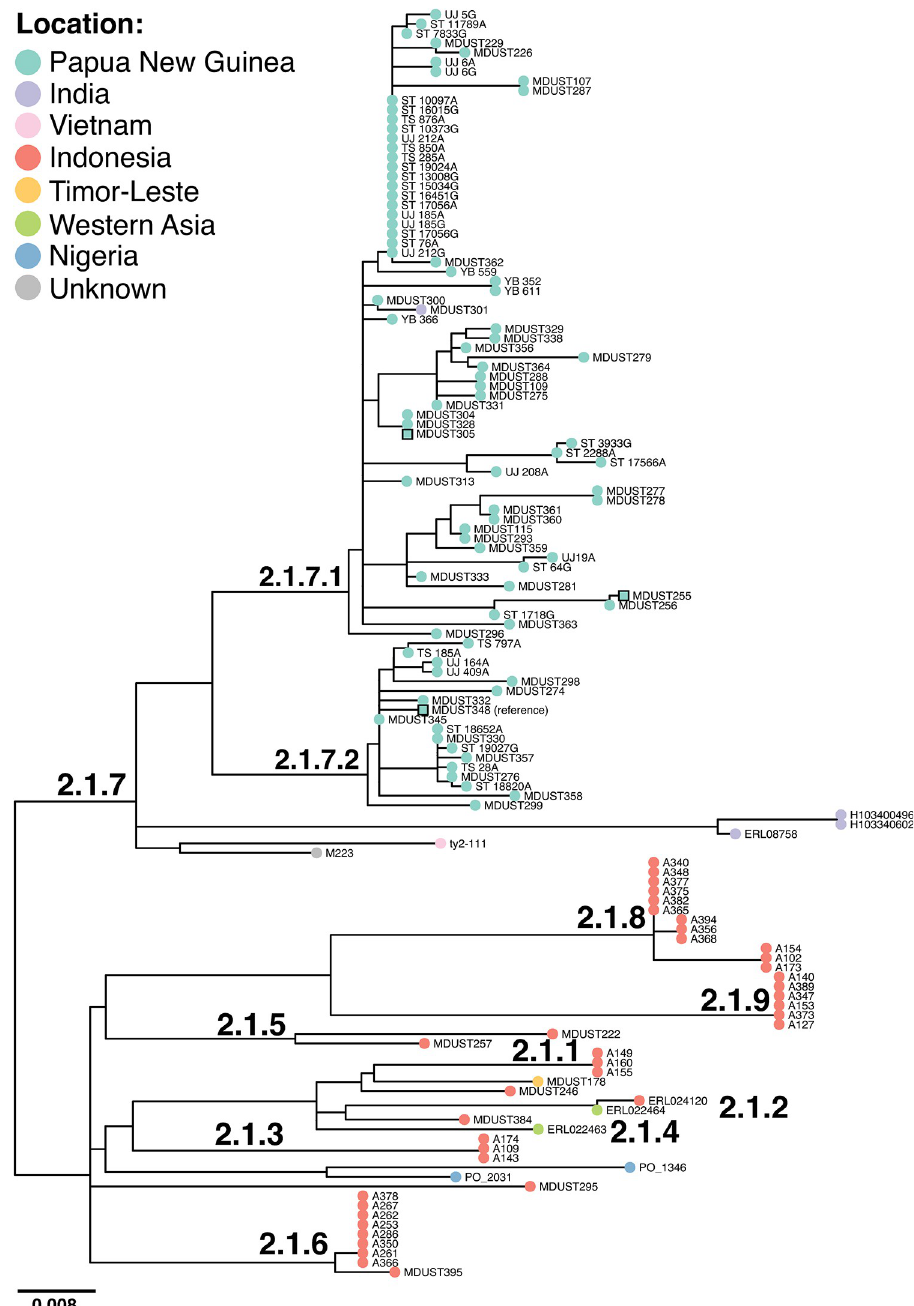
Fig 2. Maximum likelihood phylogeny inferred from all available (n = 133) clade 2.1 S . Typhi. Tips are coloured by location of origin as per inset legend (for traveller isolates, this is country of travel rather than country of isolation), branches are labelled by S . Typhi genotype. Square nodes indicate the position of the reference sequence and other completed genomes. Phylogeny is outgroup rooted with a selection of non-clade 2.1 taxa (see Methods ).